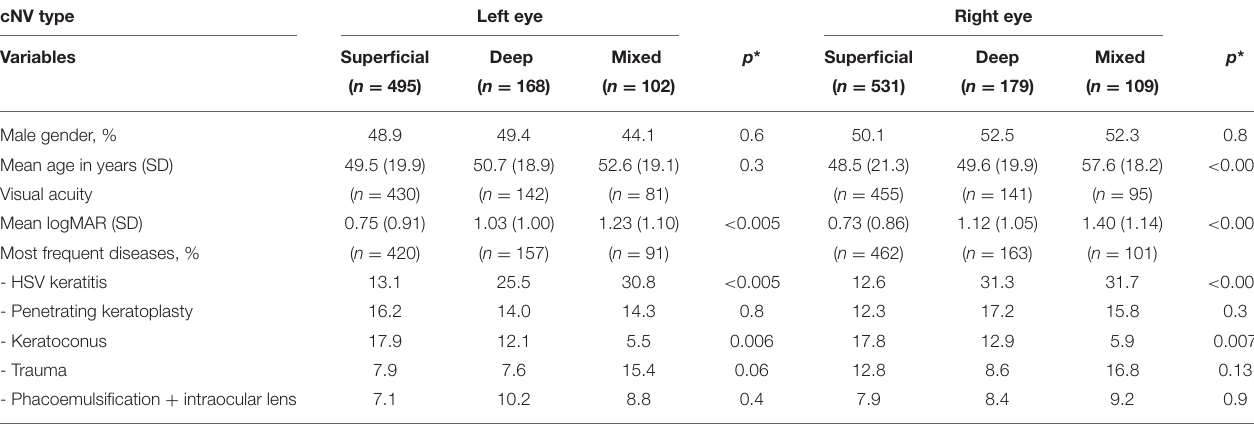
TABLE 4 | Association between corneal neovascularization (cNV) type and the most frequent diagnoses: univariate analyses. cNV type Left eye Right